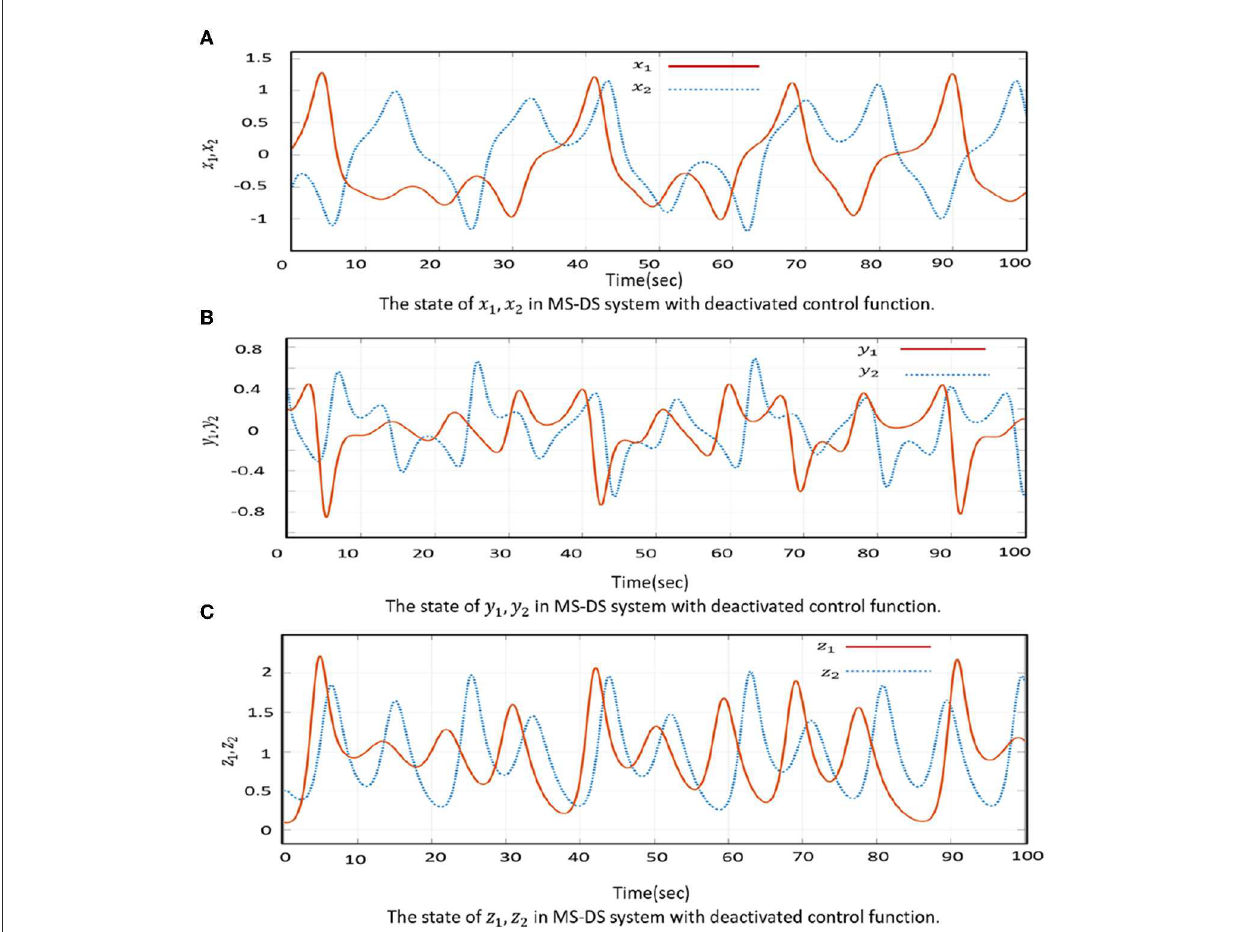
FIGURE3 Shown are the states x , y , z before synchronization in dynamical change. (A) The state of x 1 , x 2 in MS-DS system with deactivated control function. (B) The state of y 1 , y 2 in MS-DS system with deactivated control function. (C) The state of z 1 , z 2 in MS-DS system with deactivated control